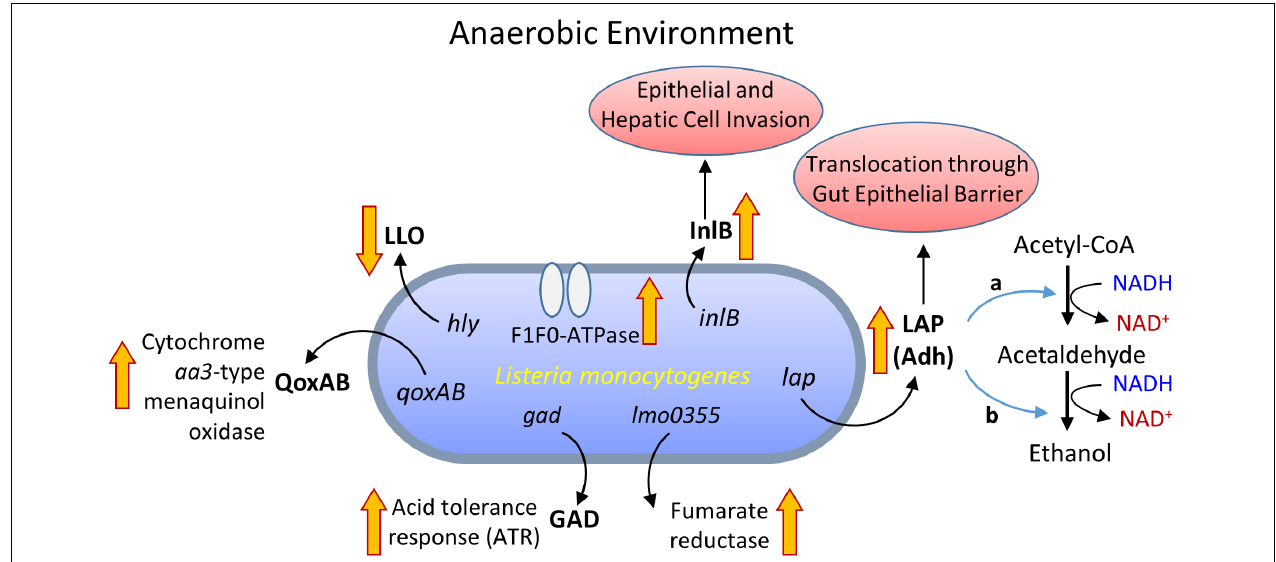
FIGURE 2 | Metabolic activity and virulence gene expression in Listeria monocytogenes under anaerobic growth environment. LLO, listeriolysin O; InlB, internalin B; QoxAB, cytochrome aa3-type menaquinol oxidase; GAD, glutamate decarboxylase; LAP, Listeria adhesion protein or alcohol acetaldehyde dehydrogenase (Adh) consists of bifunctional acetaldehyde dehydrogenase (a) and alcohol dehydrogenase